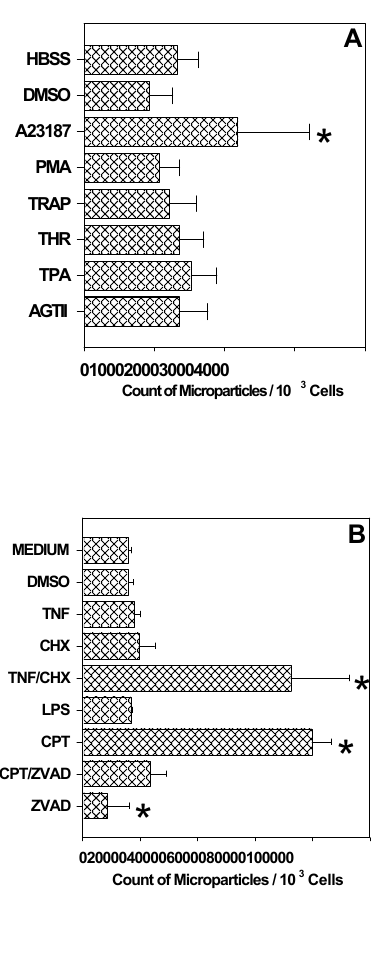
Figure 1 Release of annexin V-binding microparticles from HUVEC after stimulation with different agonistsA) Short-time stimulation (30 min): confluent HUVEC